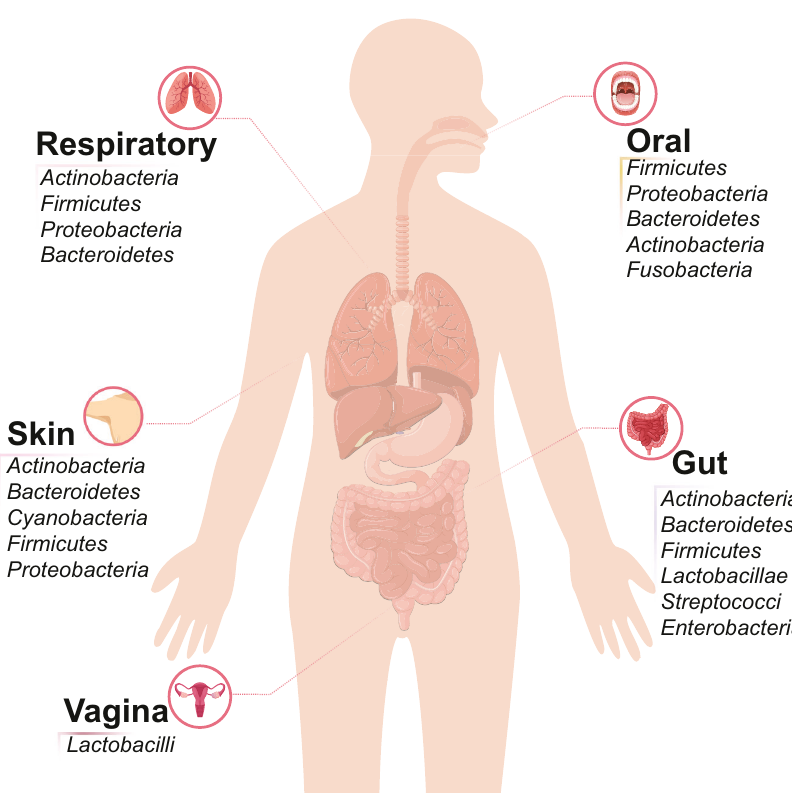
Fig. 1 Human microbiota composition in different locations. Predominant bacterial genera in the oral cavity, respiratory tract, skin, gut, and vagina are